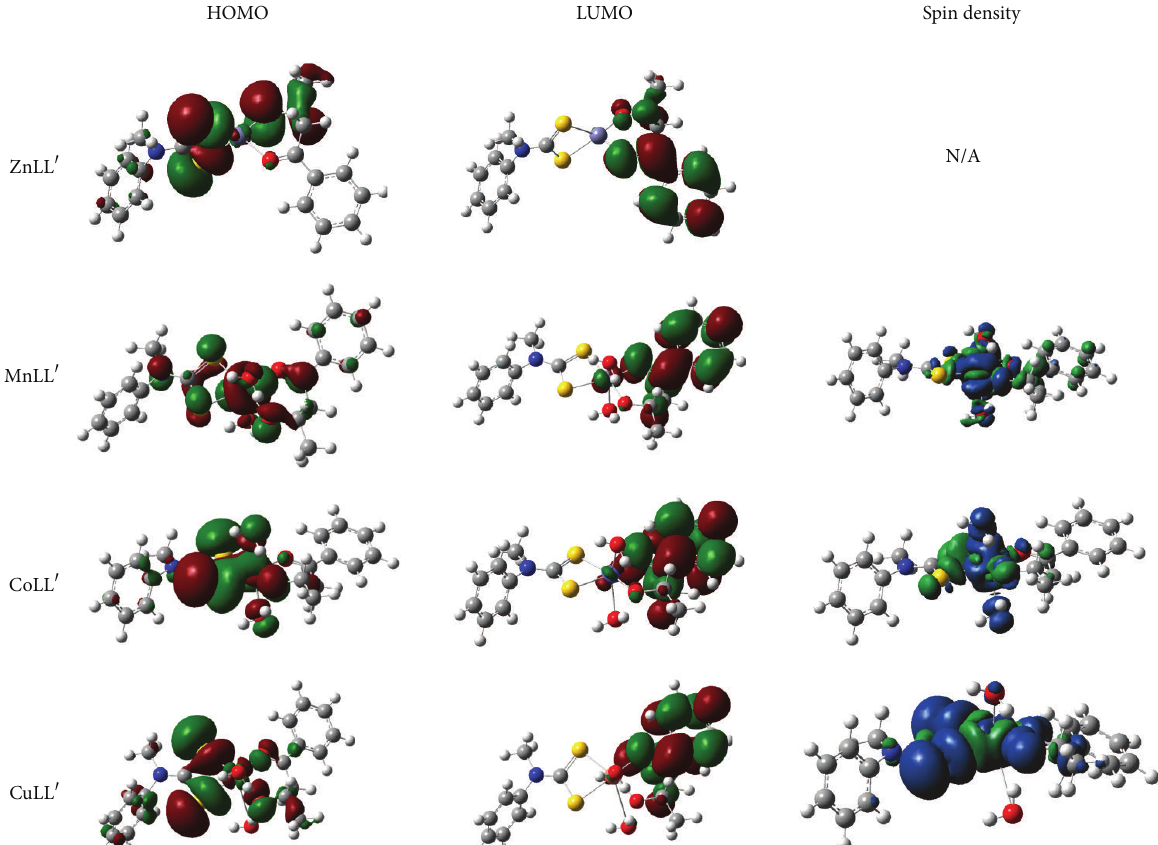
Figure 5: The graphical images of the HOMO, LUMO, and spin density electron distributions in ZnLL 󸀠 , MnLL 󸀠 , CoLL 󸀠 , and CuLL 󸀠 at